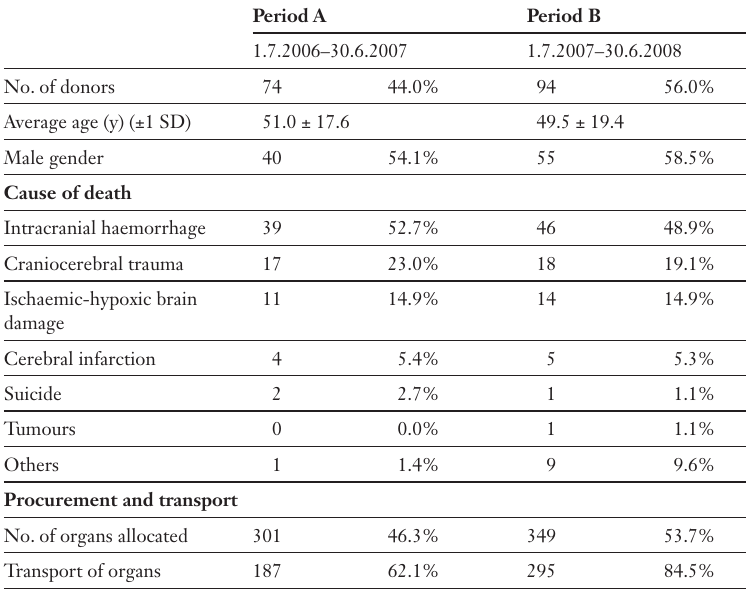
Donor characteristics, causes of death and procurement and transport modality for period A (n = 74; 44%) and period B (n = 94; 56%). Period